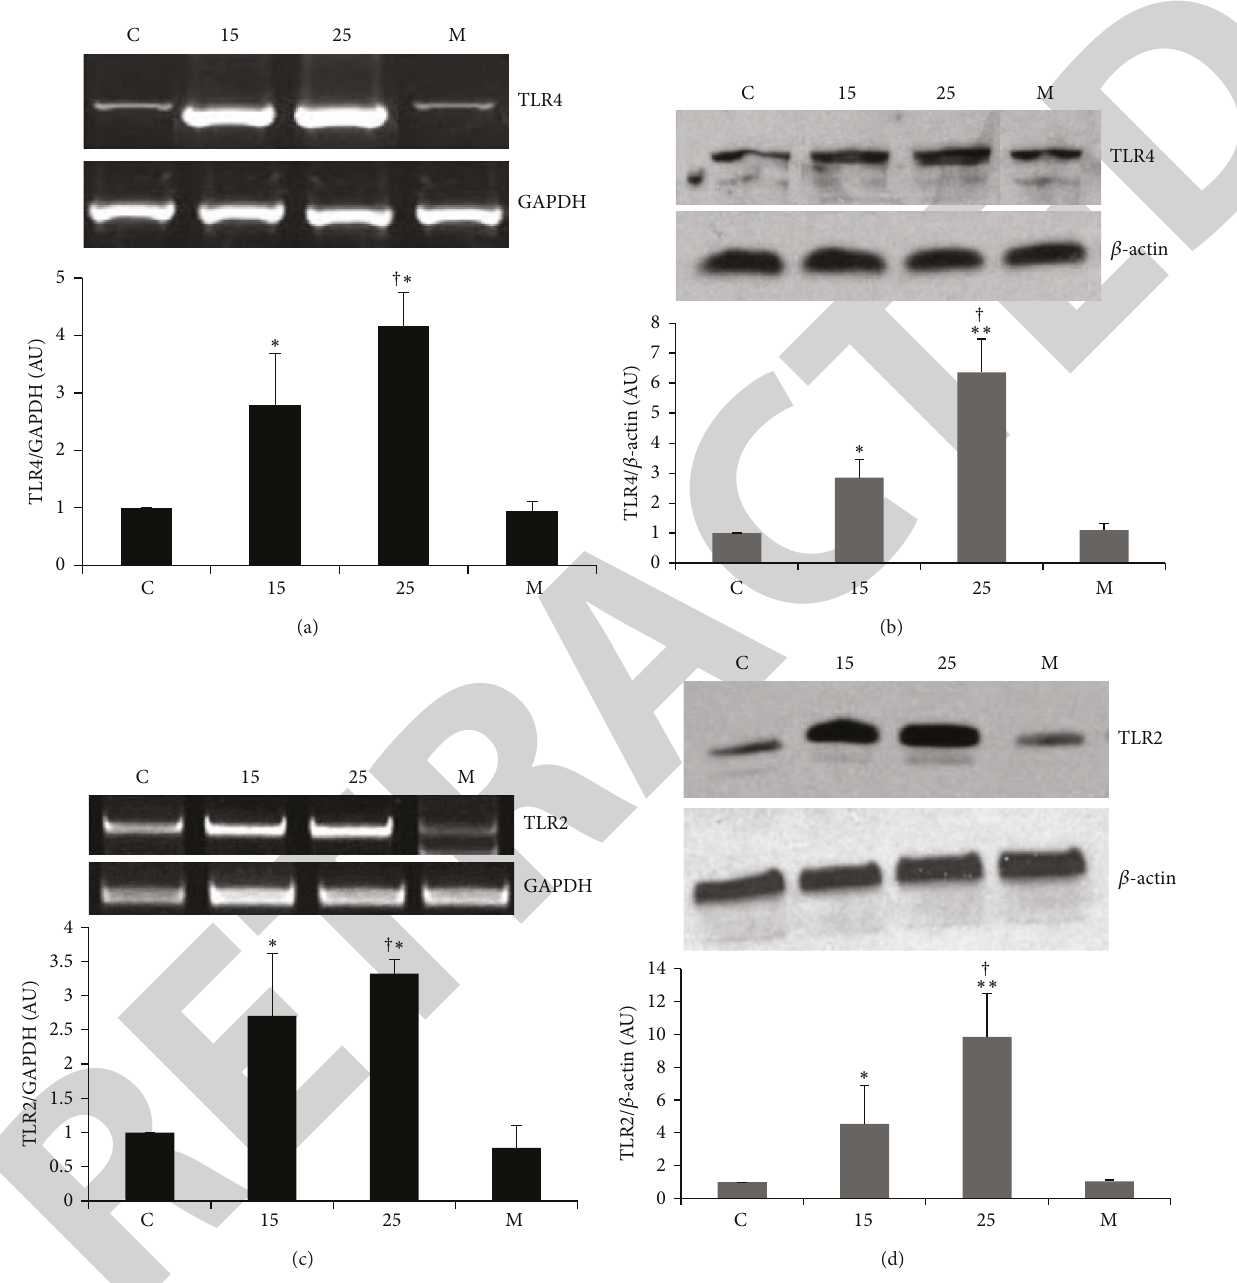
Figure 1: High glucose (HG) induces toll-like receptor-4 (TLR-4) and TLR-2: confluent HMVRECs were serum-starved for 2 hours and incubated for 24 hours with 5.5, 15, and 25 mM glucose or mannitol (M) 19.5 mM/5.5mM glucose for 24 hours. Thereafter the cells were harvested for mRNA in trizol or protease inhibitor buffer for cell lysates. (a) High glucose induces TLR-4 mRNA expression in human microvascular endothelial cells (HMVRECs). Bar graphs representing hyperglycemia-induced TLR-4 mRNA expression normalized to GAPDH. ∗ 𝑃 < 0.001 versus control and † 𝑃 < 0.01 versus 15 mM; (b) HG induces TLR-4 protein levels in HMVRECs. Bar graph representing TLR-4 protein levels normalized to 𝛽 -actin. ∗ 𝑃 < 0.01 versus control, ∗∗ 𝑃 < 0.001 versus control, and † 𝑃 < 0.001 versus 15mM; (c) high glucose induces TLR-2 mRNA expression in HMVRECs. Bar graphs representing hyperglycemia-induced TLR-2 mRNA expression normalized to GAPDH. ∗ 𝑃 < 0.001 versus control and † 𝑃 < 0.001 versus 15mM; (d) HG induces TLR-2 protein levels in HMVRECs. Bar graph representing TLR-2 protein levels normalized to 𝛽 -actin. ∗ 𝑃 < 0.05 versus control, ∗∗ 𝑃 < 0.01 versus control, and † 𝑃 < 0.05 versus